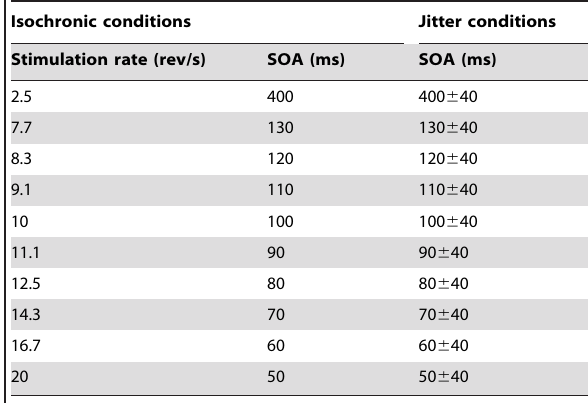
Table 2. Experiment